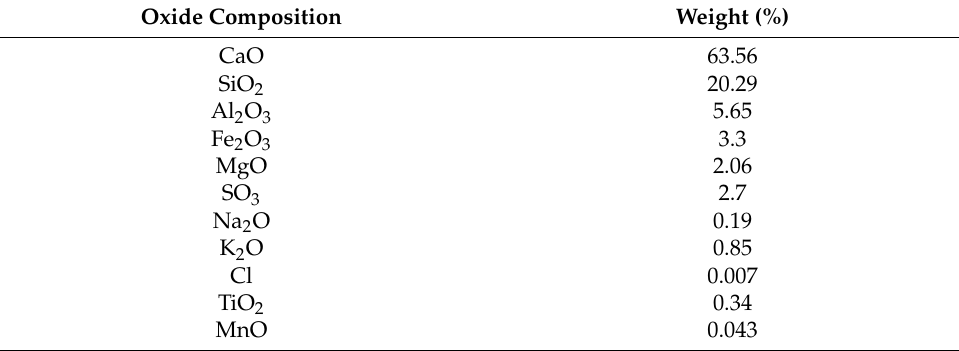
Table 2. Chemical properties of Portland